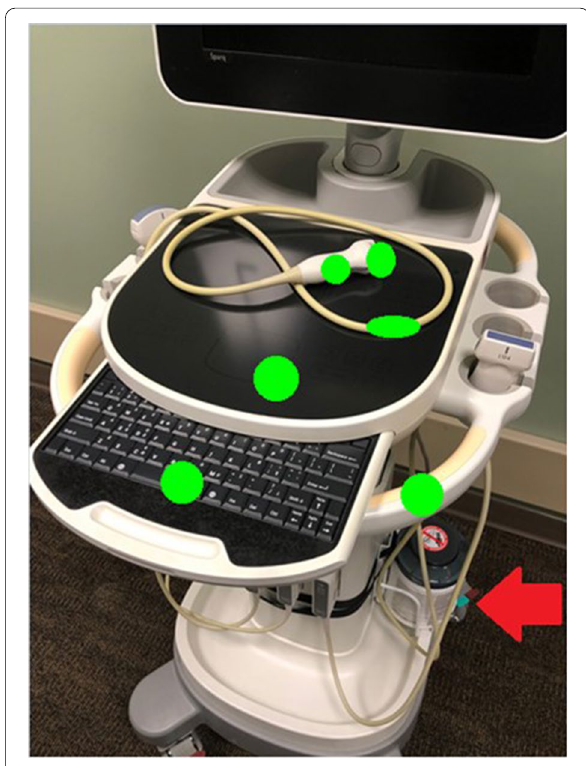
Fig. 1 Locations of fluorescent marks. A Phillips SPARQ model ultrasound machine is pictured to demonstrate marking locations. Green circles represent the areas marked with fluorescent gel during the study (size exaggerated for clarity). For simplicity, only one probe and cord is displayed, but all probes and cords were marked in this fashion during the study. Also pictured is the disinfecting wipe caddie that was added to these models to improve access to cleaning supplies (red